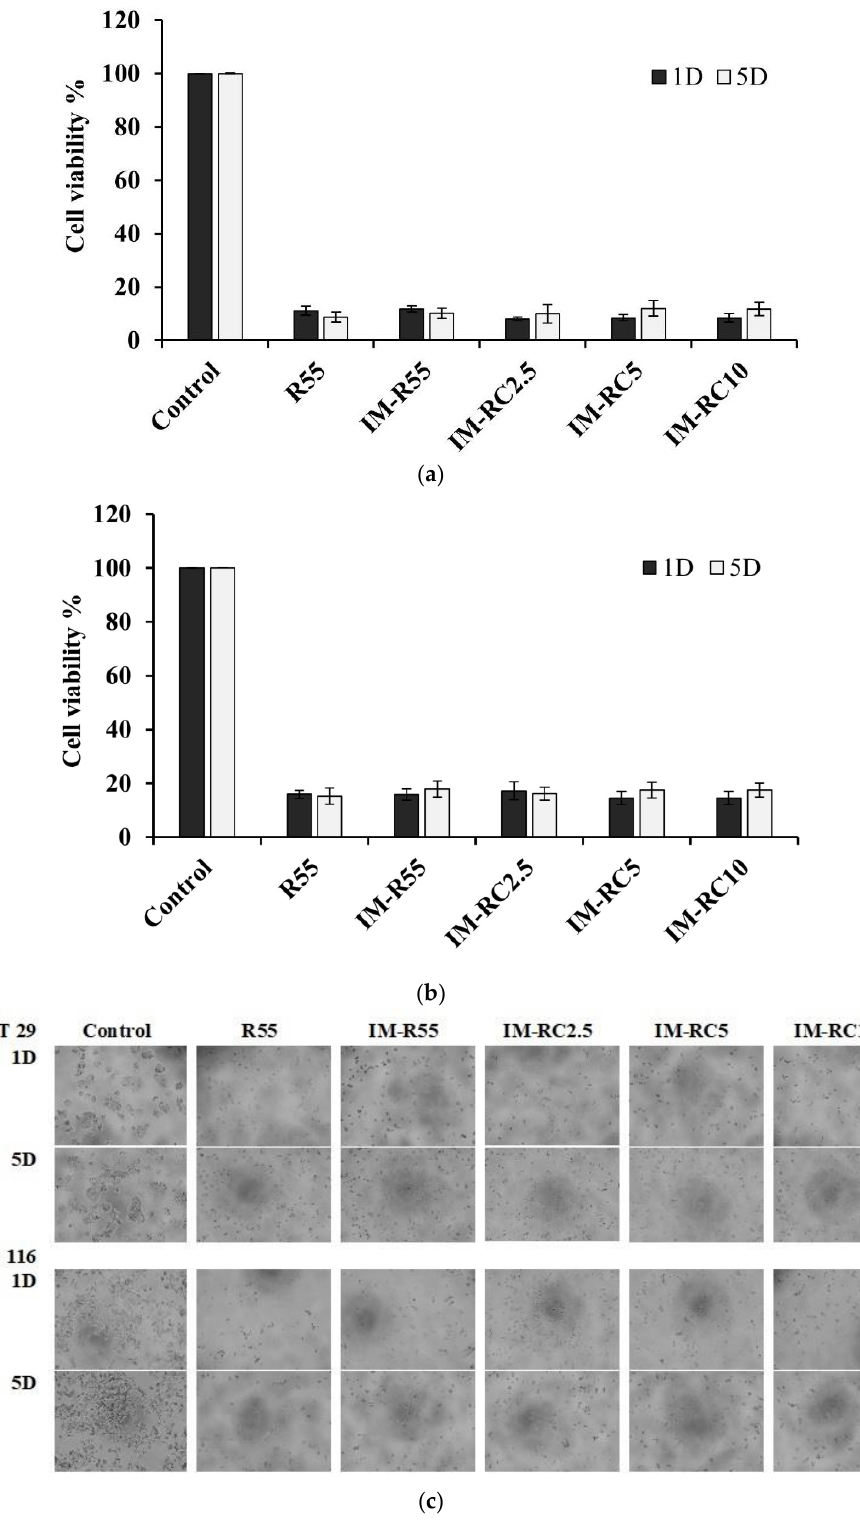
Figure 9. Cell viability of ( a ) HCT-116 and ( b ) HT-29 cells exposed to an extracted medium from IM-loaded rosin/CO-based ISG formulations at 1 and 5 days. ( c ) Images showing the morphology changes of the HT-29 and HCT-116 cells treated with the control and extracted medium from ISG formulations after incubation for days 1 and 5 using inverted microscope (×40 magnification).